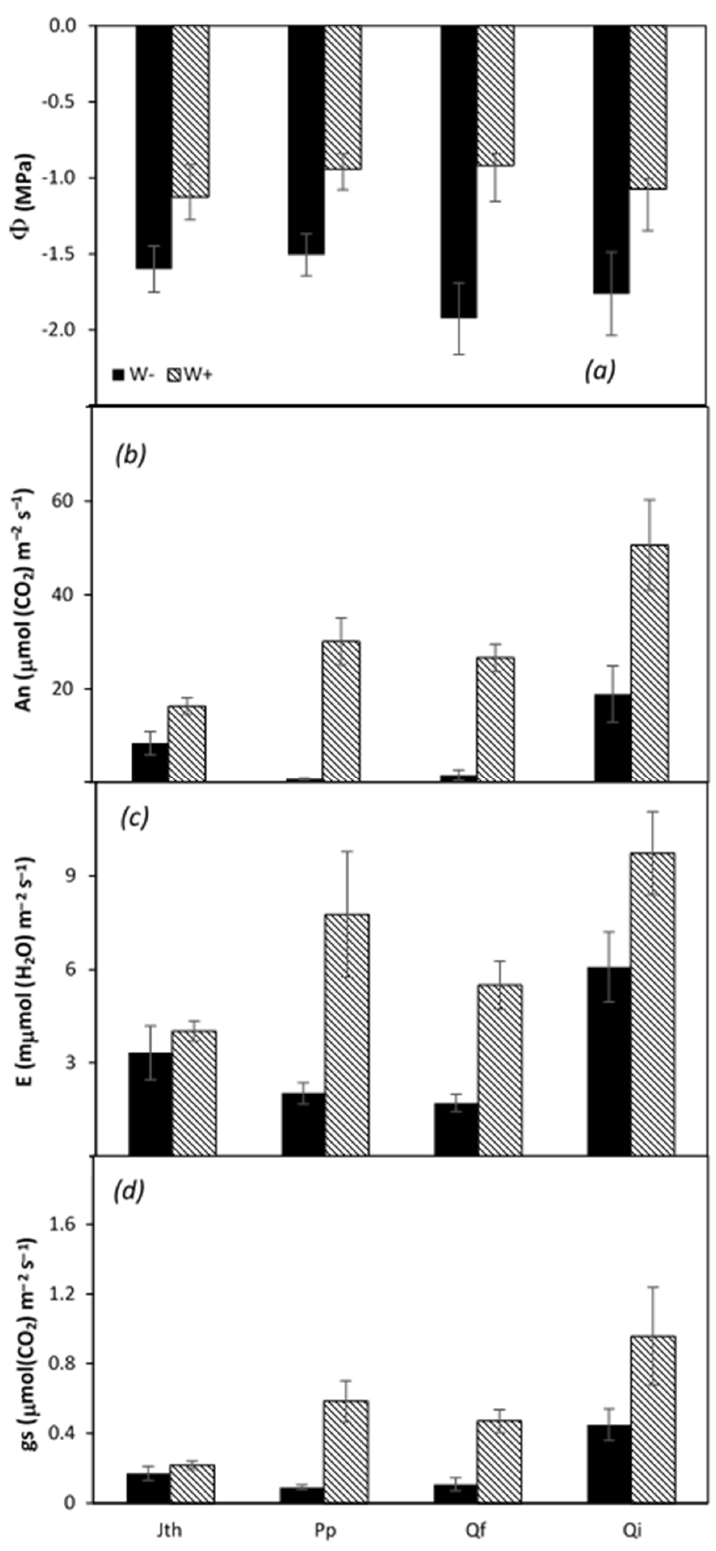
Figure 5. ( a ) Water potential ( Φ , MPa), ( b ) net photosynthesis (An, µ mol(CO 2 ) m − 2 s − 1 ), ( c ) transpiration (E, mmol(H 2 O) m − 2 s − 1 ) and ( d ) stomatal conductance (gs, µ mol(CO 2 ) m − 2 s − 1 ) in water stressed (W − ) vs. well-watered (W+) seedlings of the four studied species, after the 2-months severe drought period (Jth: Juniperus thurifera, Pp: Pinus pinea, Qf: Quercus faginea, Qi: Quercus ilex). See Table S2 for statistical